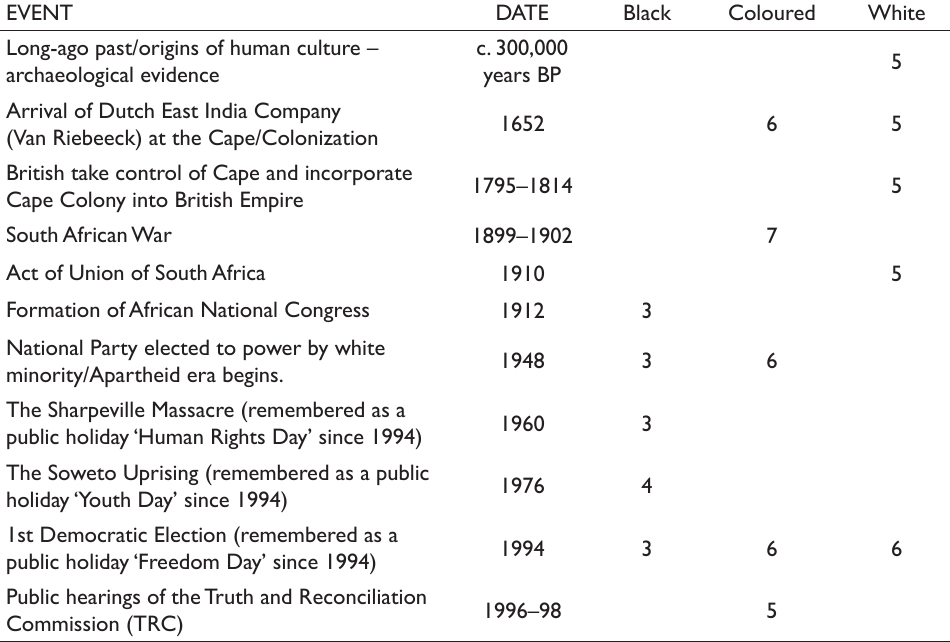
Table 2: Topfiveeventsmentionedinstudents’narratives(withorwithoutuseofaspecificdate),by